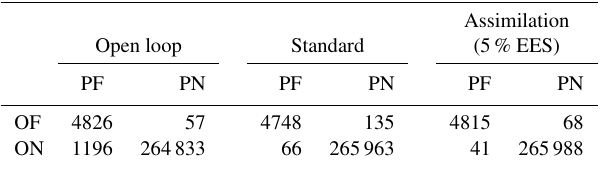
Table 2. Confusion matrix of the OL and of the 5% EES assimi- lation at the fourth assimilation time step (OF = observed flooded pixels in the truth map, ON = observed non-flooded pixels in the truth map, PF = predicted flooded pixels, and PN = predicted non- flooded